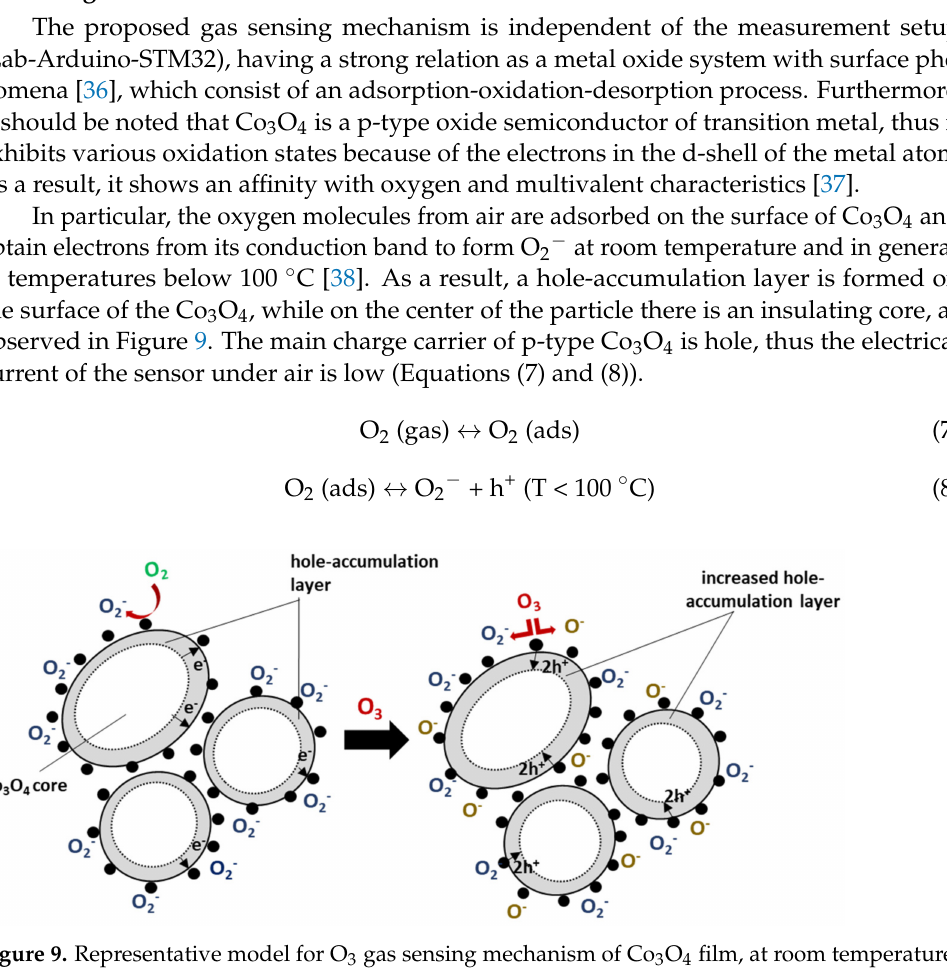
Figure 9. Representative model for O 3 gas sensing mechanism of Co 3 O 4 film, at room